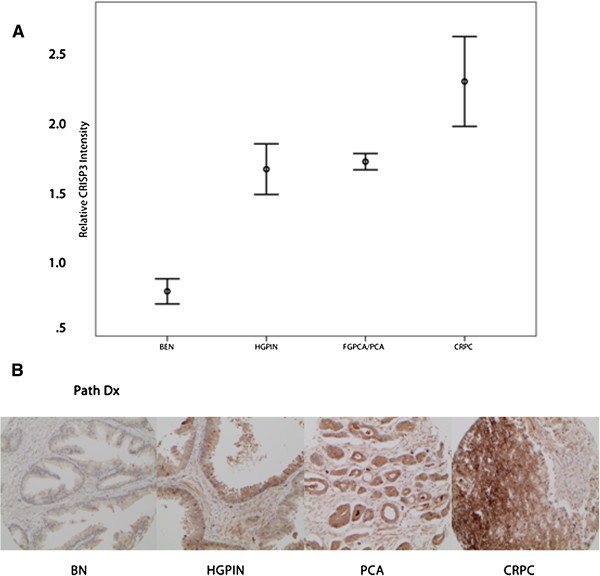
CRISP3 protein expression across different stages of PCA progression. A. Error bars of mean intensity of CRISP3 protein expression in benign prostate tissue (BN), high grade intraepithelial neoplasia (HGPIN) and localized prostate cancer (PCA). B. Examples of CRISP3 expression in Benign, HGPIN, localized prostate cancer (PC) and castration resistant prostate cancer (CRPC).